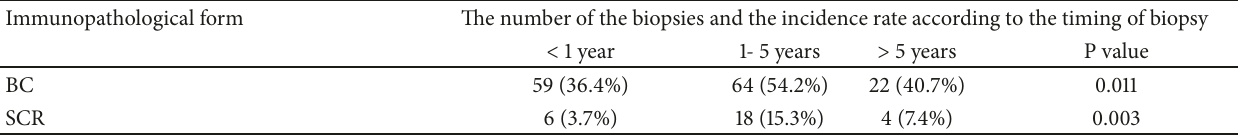
Table 2: The number of the biopsies and the incidence rate according to the timing of biopsy. Immunopathological form